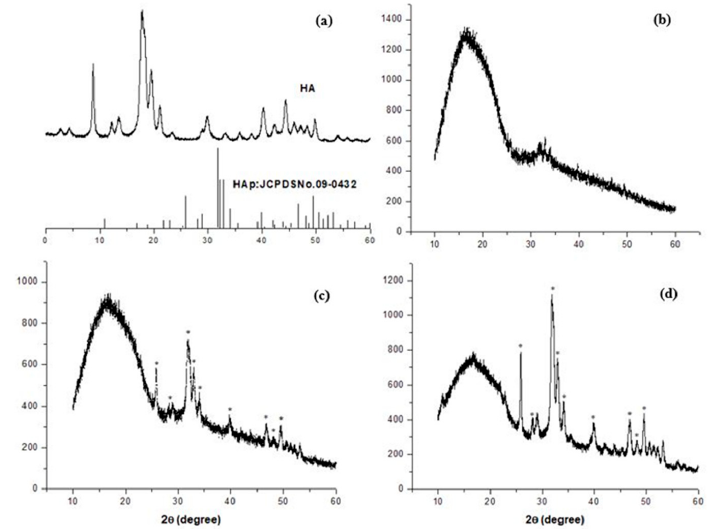
Figure 4. XRD patterns of ( a ) the locally extracted HA powder; ( b ) PLA / PCL, ( c ) PLA / PCL / 5HA, and ( d ) PLA / PCL / 15HA filaments.